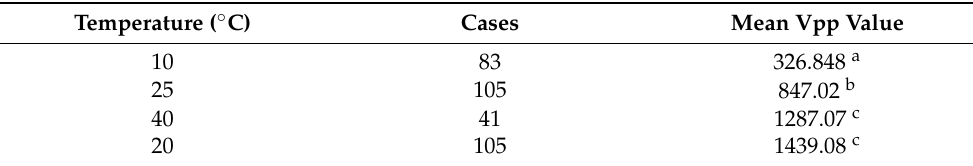
Table 14. Duncan’s Multiple Range Test for Temperature of Two-Way ANOVA results for Vpp with selected